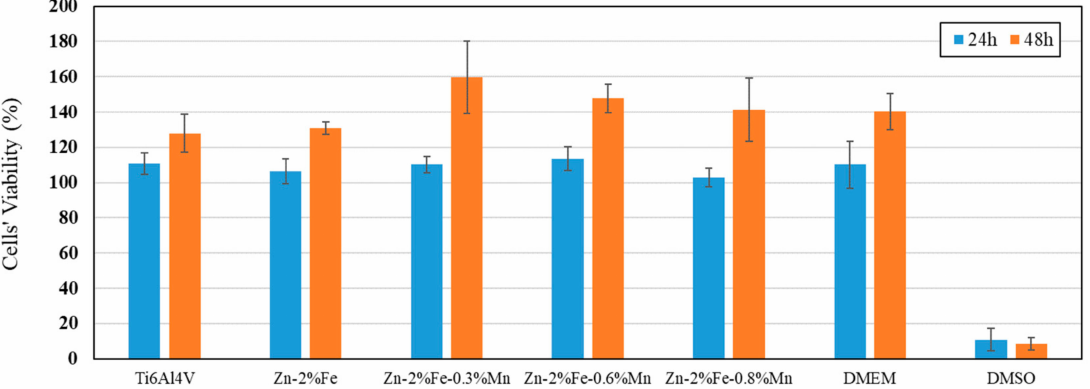
Figure 12. Indirect cell viability analysis of the tested alloy after incubation times of 24 and 48 h.